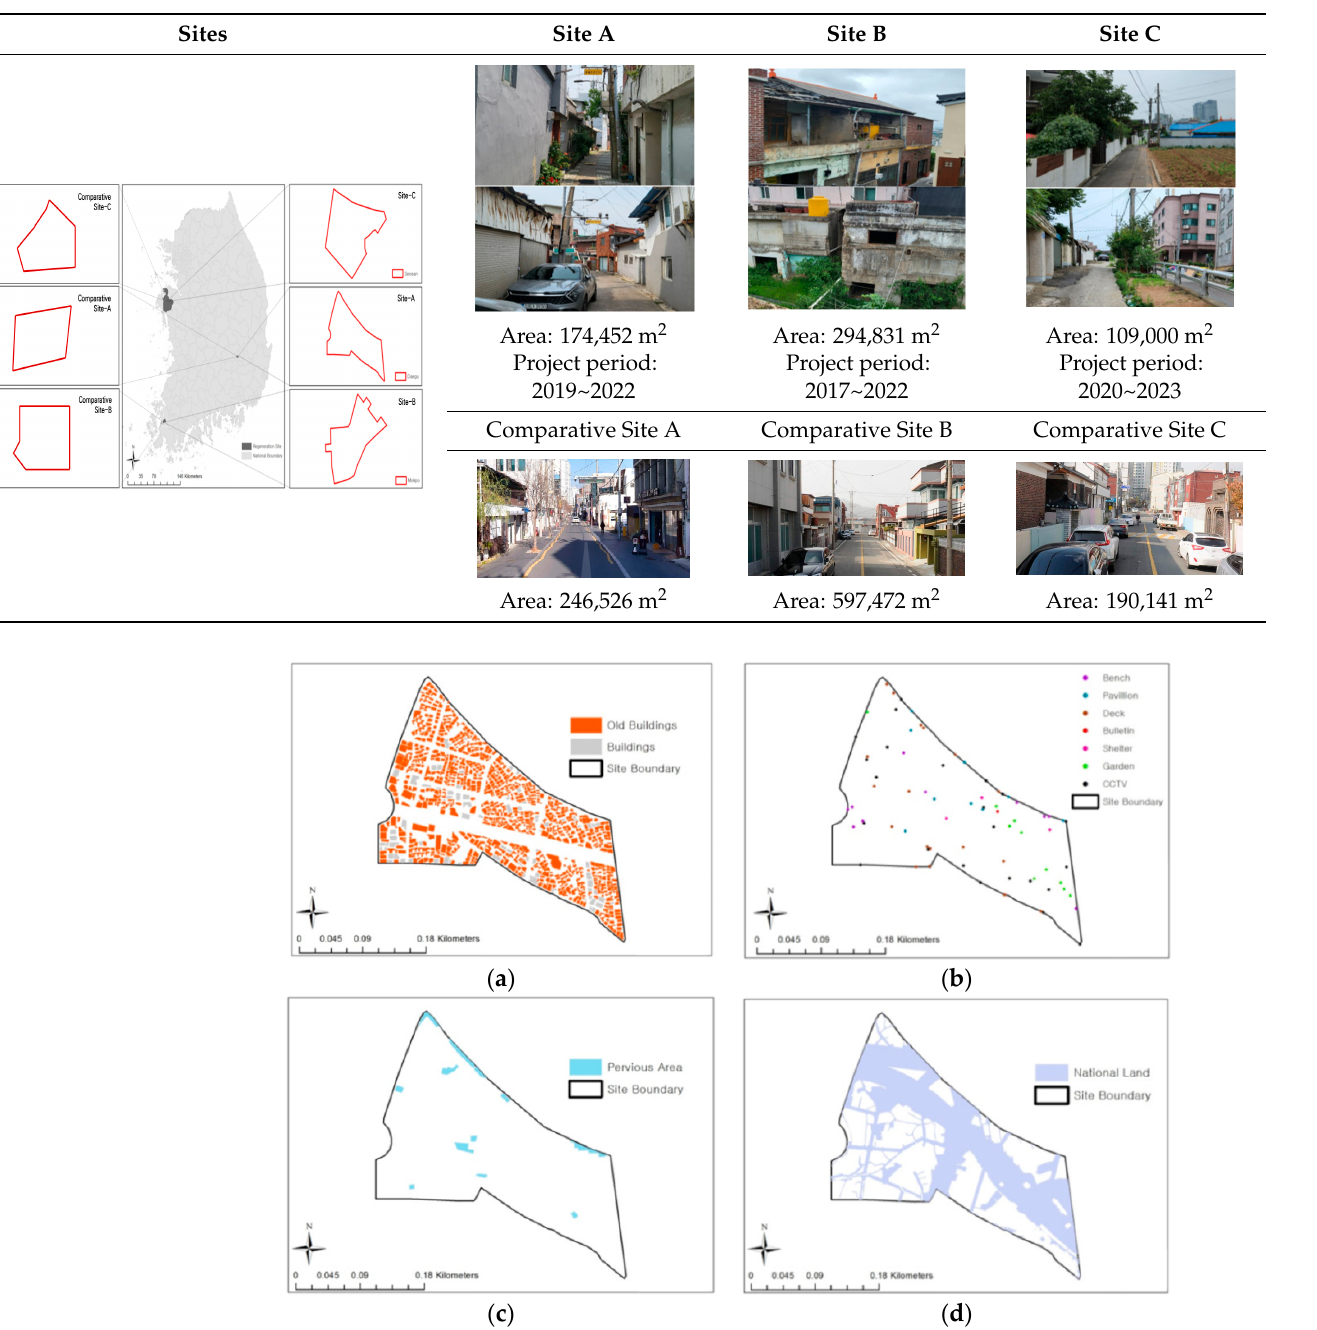
Table 3. The condition of target sites. Sites